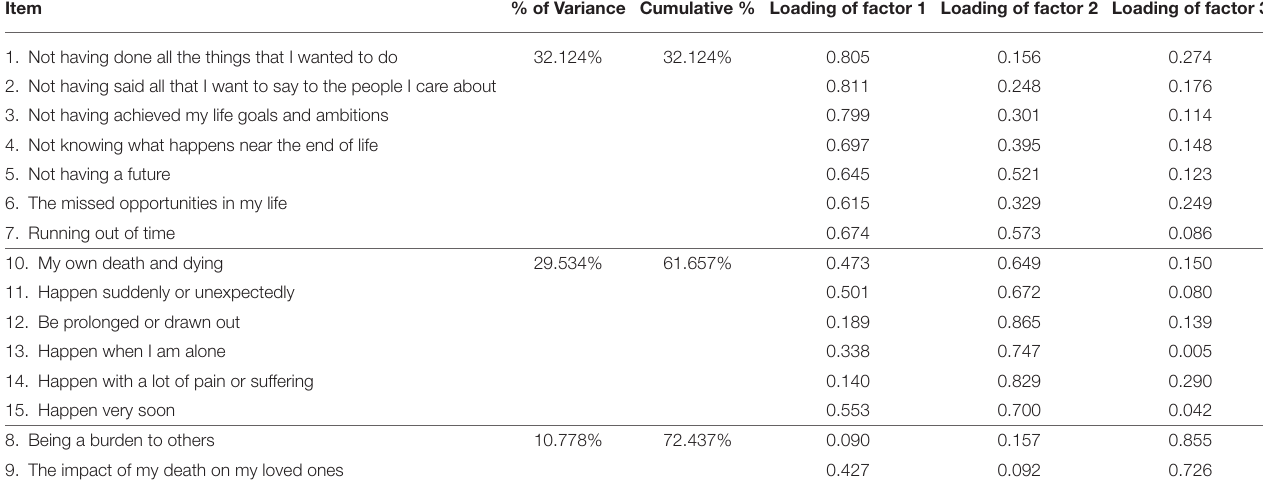
TABLE 2 | Exploratory factor analysis of DADDS-C by Scree Plot (Eigenvalue > 1).